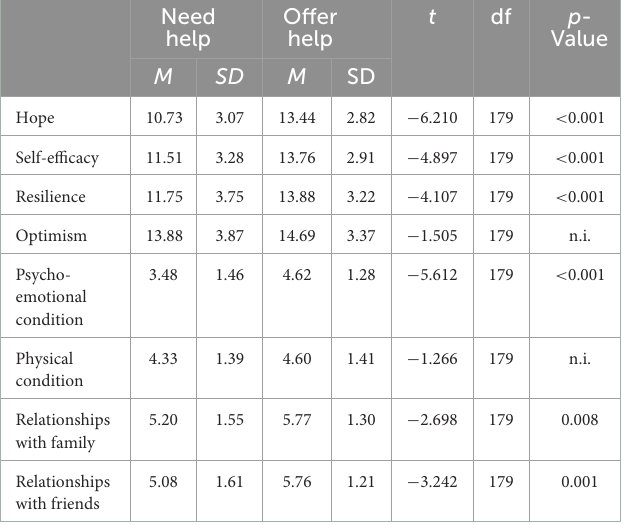
TABLE 3 List of possible forms of needed/offered aid and help needs of refugees.